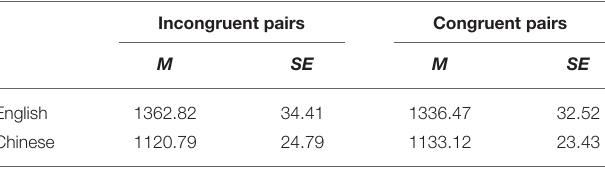
TABLE 2 | Mean RTs and SE for English and Chinese groups.